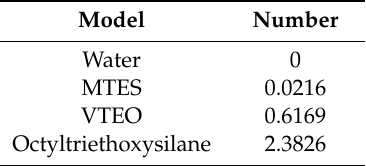
Table 2. Number of adsorbed ions* onto the C–S–H channel at 2000 ps. MTES—methyltriethoxysilane;